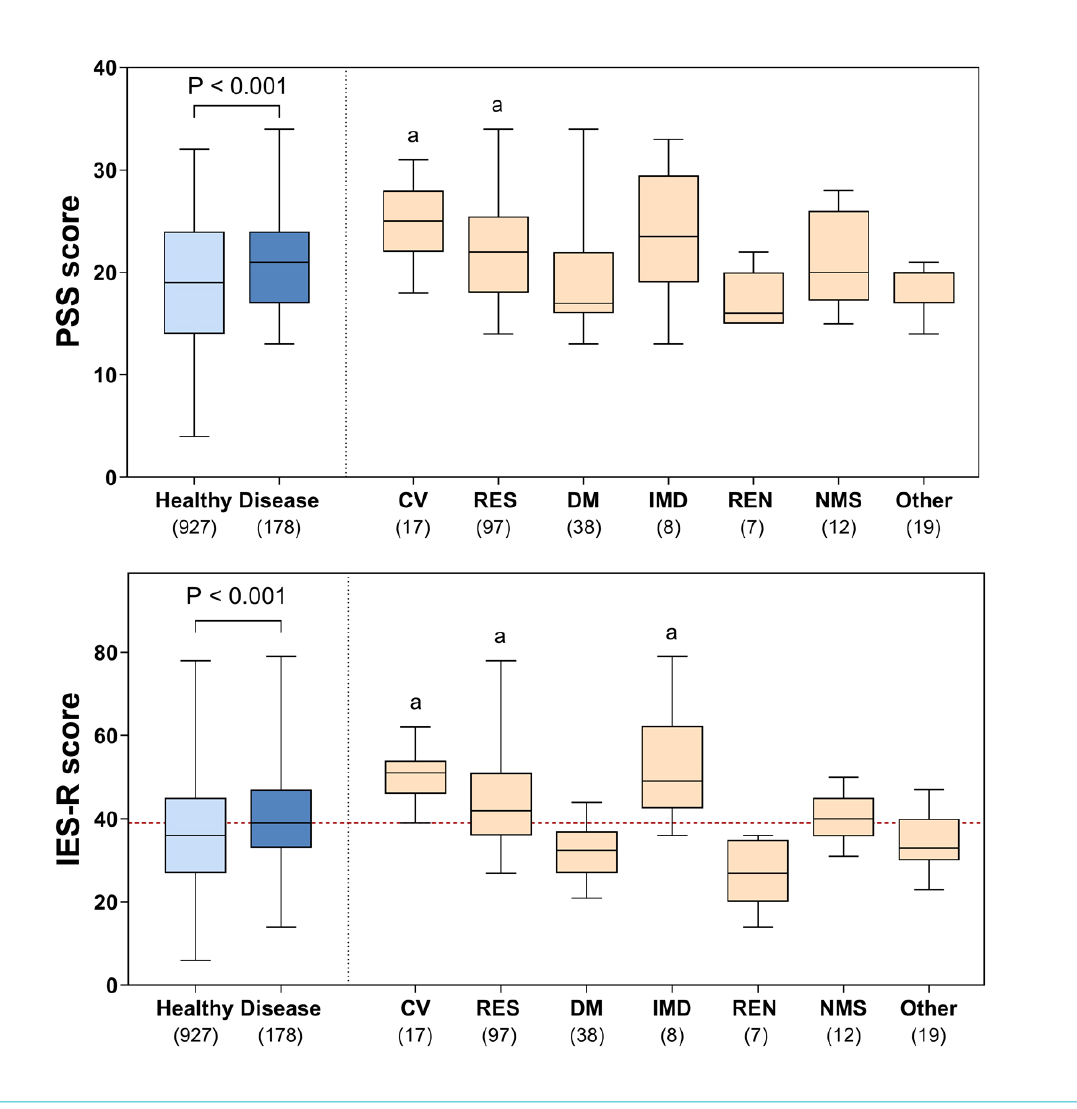
Figure 1: PSS and IES-R scores (box-and-whisker plots with median, 75th percentile and range). Left panels: score comparisons between parents of healthy children and those of children with underlying disorders (Mann-Whitney U-test). Right panels: comparisons of parental scores among children with underlying disorders (n = 198) (Kruskal-Wallis test with Dunn’s post-hoc test for multiple comparisons). Red dotted line: cut-off for diagnosis of post-traumatic stress disorder. Number of cases are given in parentheses. a: significantly higher (p <0.01) com- pared with DM, REN and “other” disorders. CV =cardiovascular disorders (congenital heart disease, heart failure); RES = respiratory disorders (asthma, chronic lung disease of prematurity); DM = diabetes mellitus; IMD = immunodeficiency (including chemotherapy) REN = renal disor-